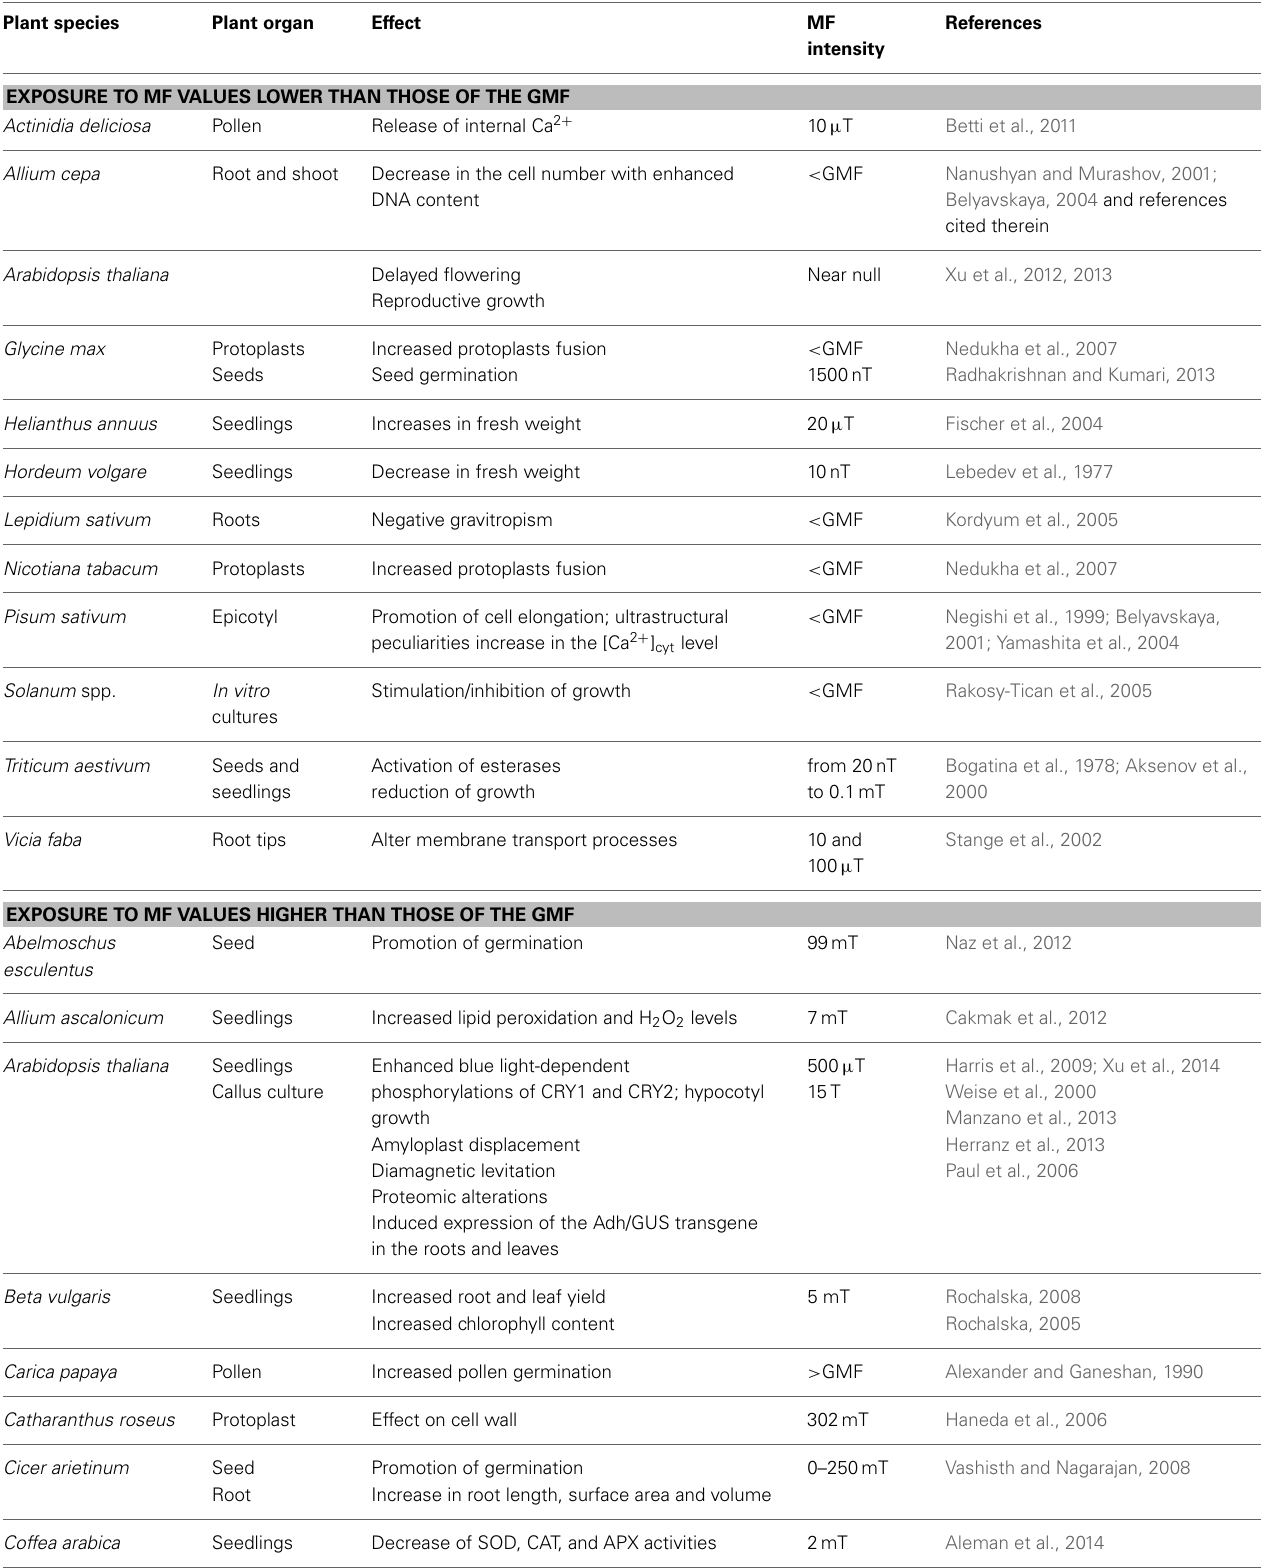
Table 1 | Summary of magnetic field (MF) effects on plants. Plant